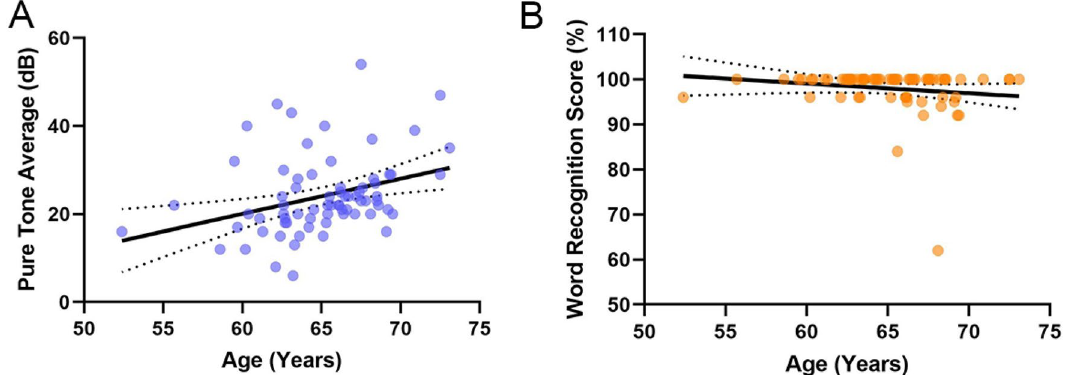
Figure 2. Scatterplots showing age and hearing distribution and their relation. ( A ) Mean pure-tone ( A ) and word-recognition score ( B ) versus